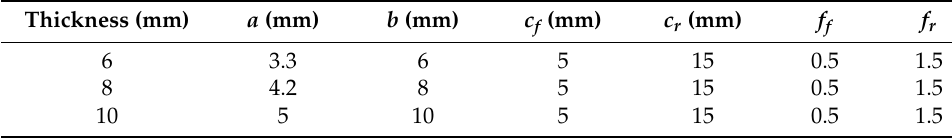
Table 5. Heat source parameters for different thicknesses.